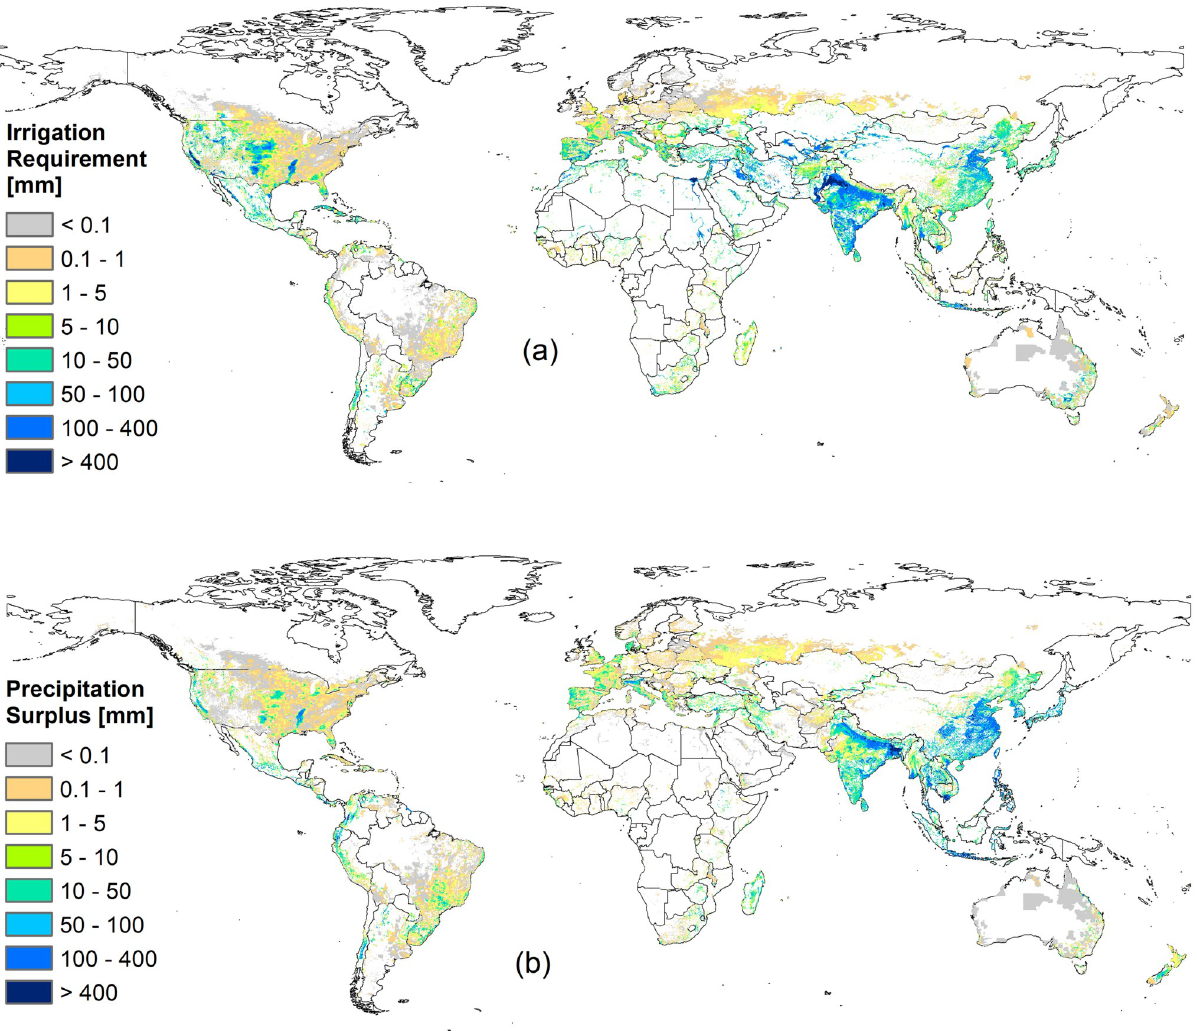
Fig 3. Spatial distribution of irrigation requirement and precipitation surplus. Cell-average water depths [mm], as a ratio between the total volume cumulated over the year within the cell and the cell